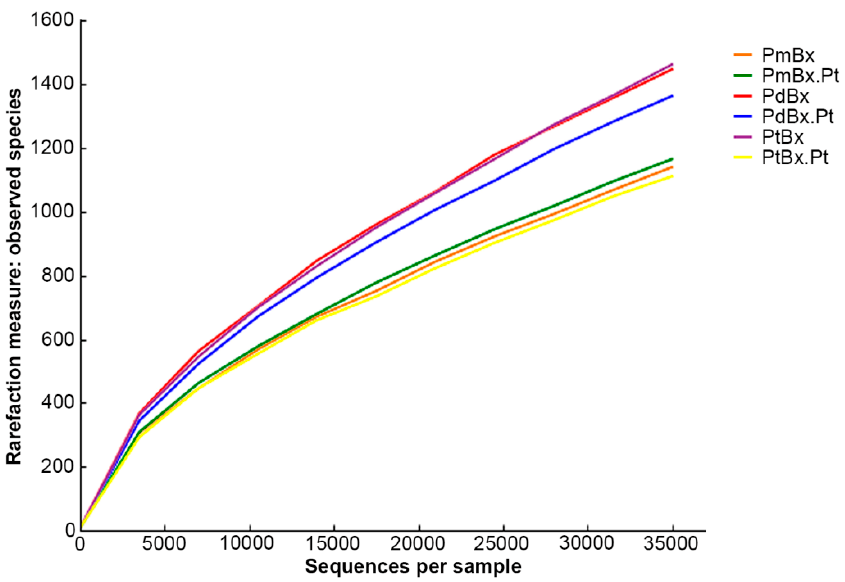
Figure 4. Rarefaction analysis of bacteria associated with different Bursaphelenchus xylophilus 142